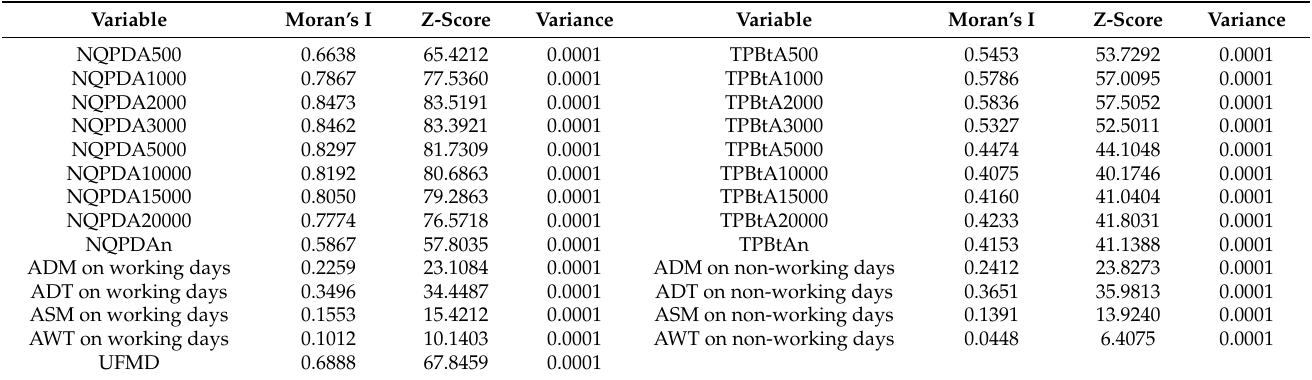
Table 5. Spatial autocorrelation analysis results of explanatory